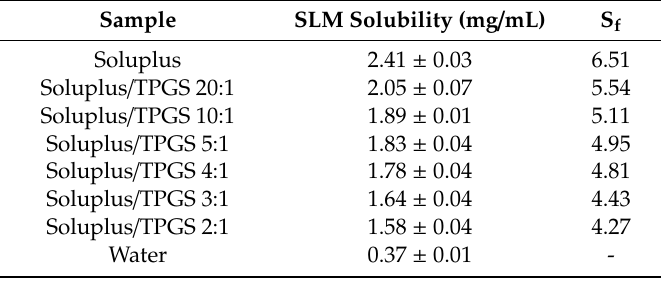
Table 2. SLM solubility and solubility factor in PNM, MNM and water at room temperature (Mean ± SD, n =